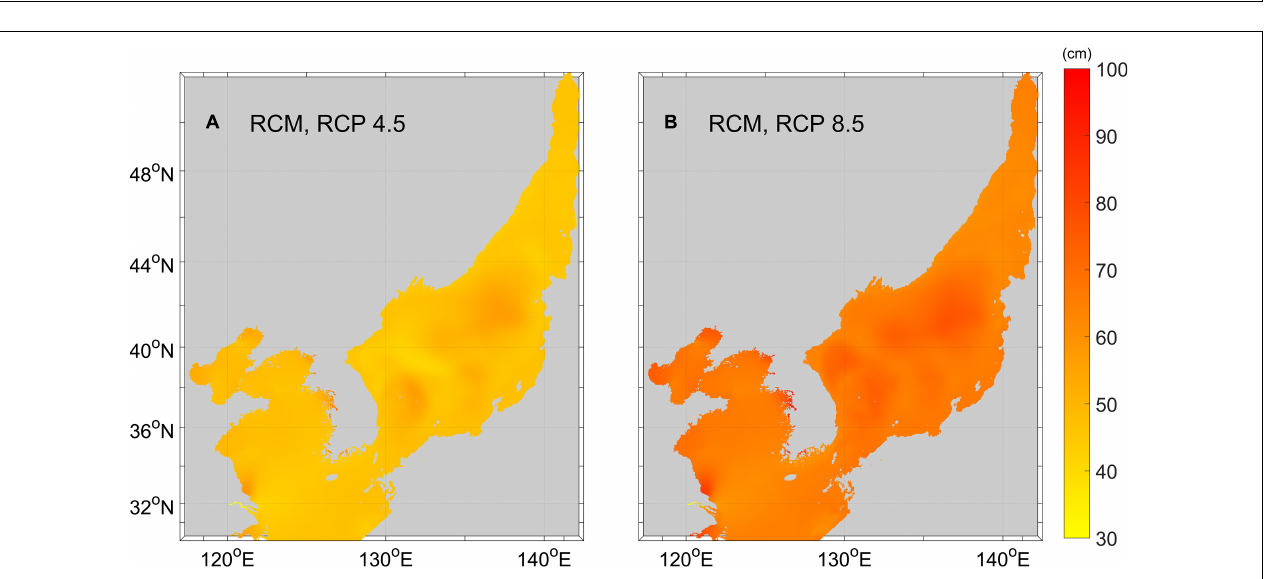
FIGURE 12 | Horizontal distributions of the practical sea-level rise (PSLR; unit: cm) for the RCMs between 1986–2005 and 2081–2100, under: (A) RCP 4.5 and (B) RCP 8.5 scenarios.